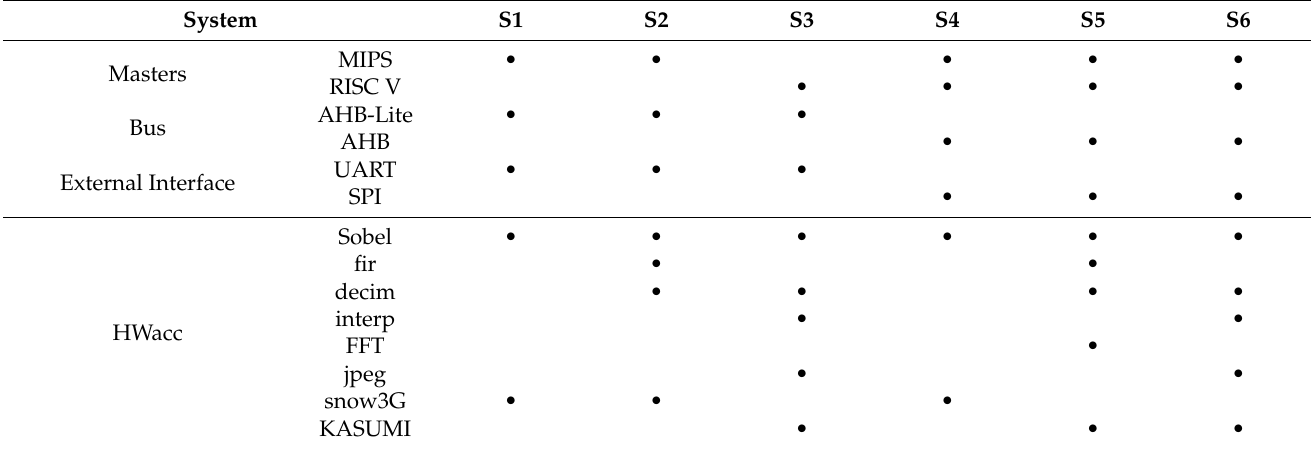
Table 5. System benchmarks’ configuration